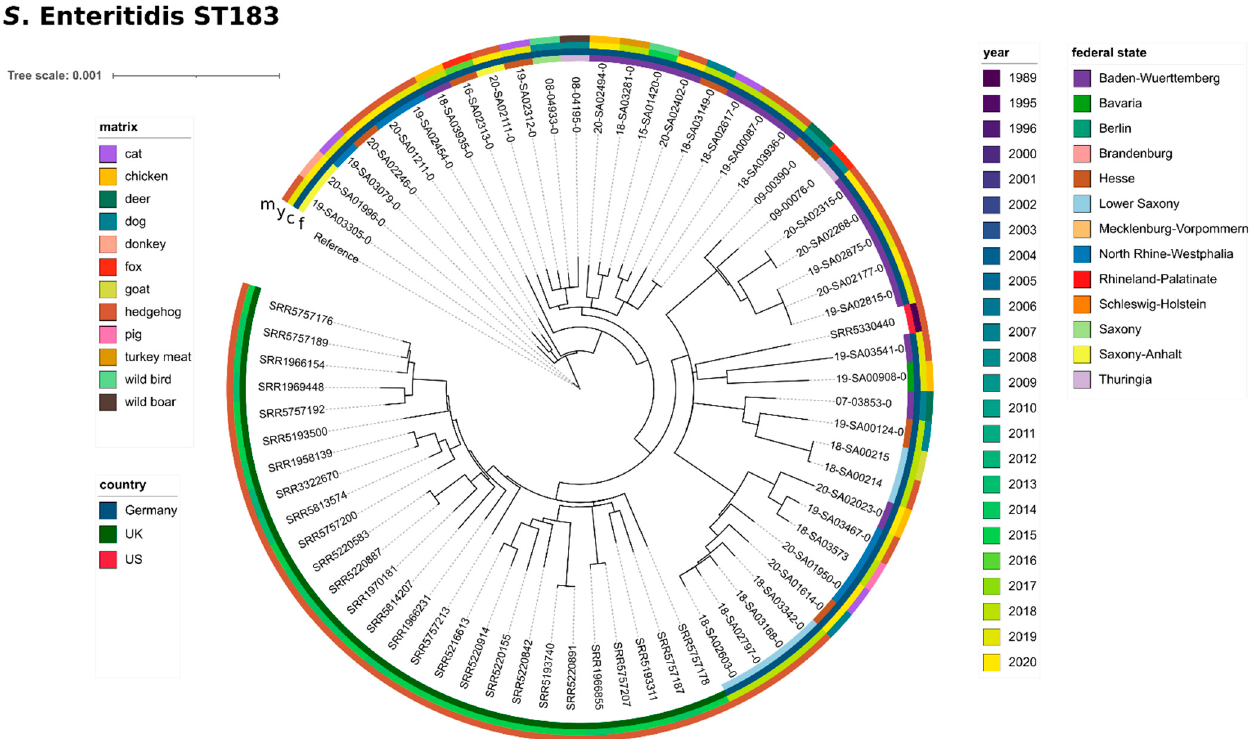
Figure 5. Phylogenetic relationship between S. Enteritidis (ST183) wildlife isolates and isolates from food, feed and farm animals. Maximum likelihood phylogenetic tree based on core SNPs in the bacterial chromosome. For lack of a publicly available complete genome sequence for S. Enteritidis ST183, a draft assembly of 19-SA03305-0 was used as a reference. The tree was computed with the snippySnake pipeline with IQ-TREE, visualized in iTOL and manually rooted to the reference. The colour bars (inside to outside) identify the German federal state (f), national country (c), sampling year (y) and matrix (m) of the samples. Isolates carrying antimicrobial resistance genes are highlighted in colour with the type of resistance genes indicated. The scale bar shows the genomic distances of the sequences in substitutions per site.